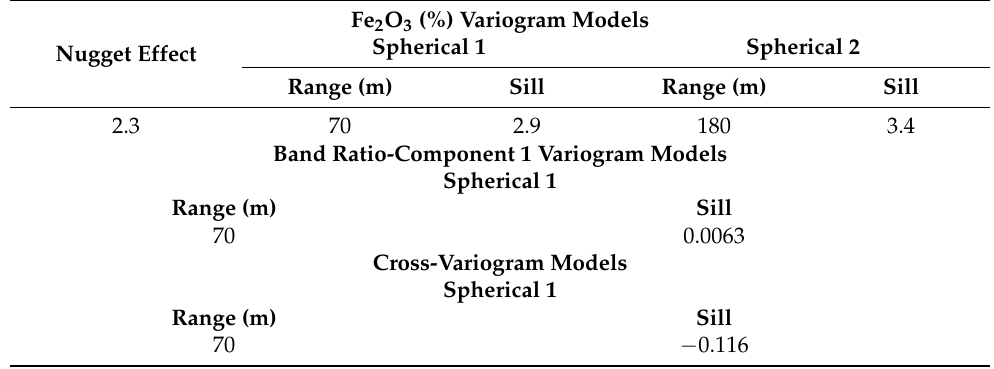
Table 4. Main parameters of the variogram model from Fe 2 O 3 (%) of samples, first component of ferrous iron oxides band ratio and